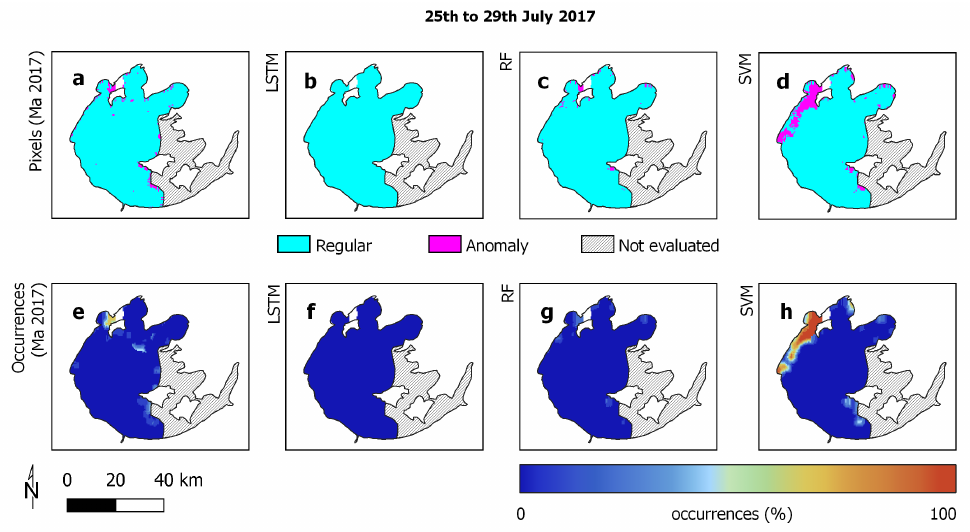
Figure 16. Period trend forecasting based on pixels ( a – d ) and occurrences ( e – h ) from 25–29 July 2017, related to Lake Taihu. Plots ( a , b ) represent the mapping of the reference